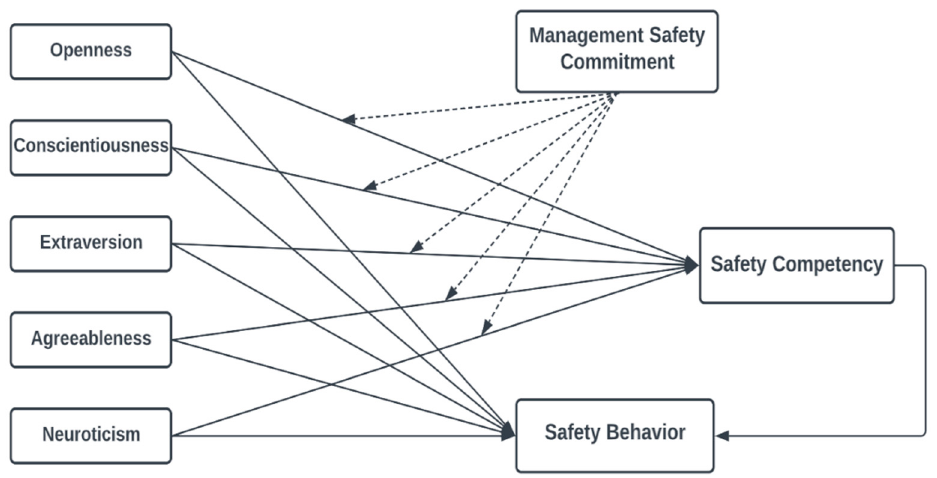
Figure 1. Conceptual